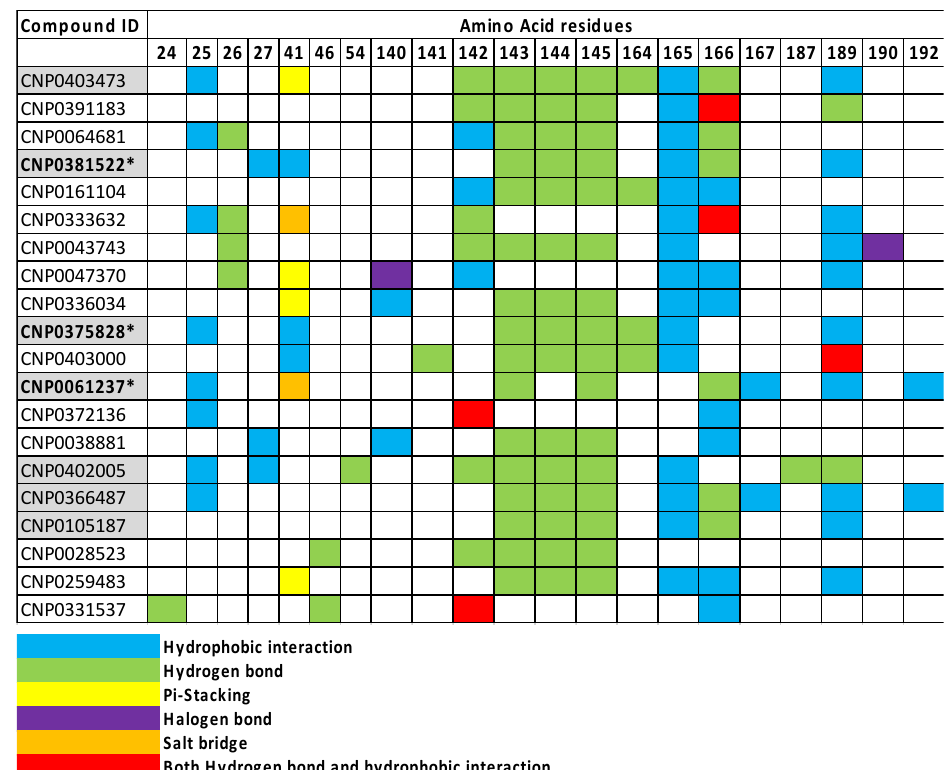
Figure 4. The interactions of the top 20 NP ligands with 6LU7 M pro amino acid residues. The specific types of interactions between the ligands and the 21 amino acid residues of the M pro are designated by different colors. The NP COCONUT ids are presented on the y -axis and amino acid residues of M pro on the x -axis. The gray color indicates the seven in vitro tested compounds. COCONUT Ids in bold, gray color and with asterisk show in vitro inhibition with IC50 less than 4.52 × 10 -4 M.